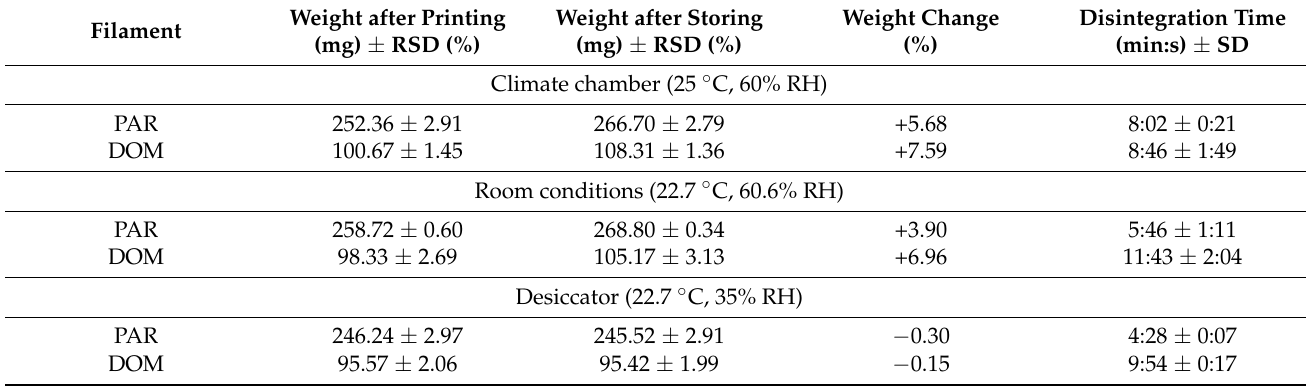
Table 3. Comparison of the attributes of tablets with basic shape immediately after printing and after 24 h of storage in various